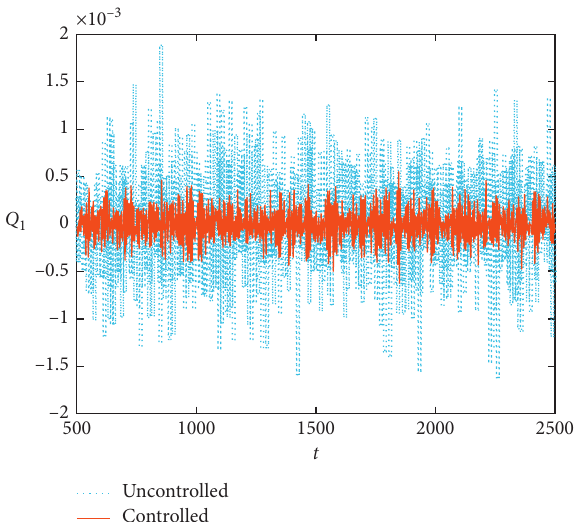
Figure 4: Sample of process q